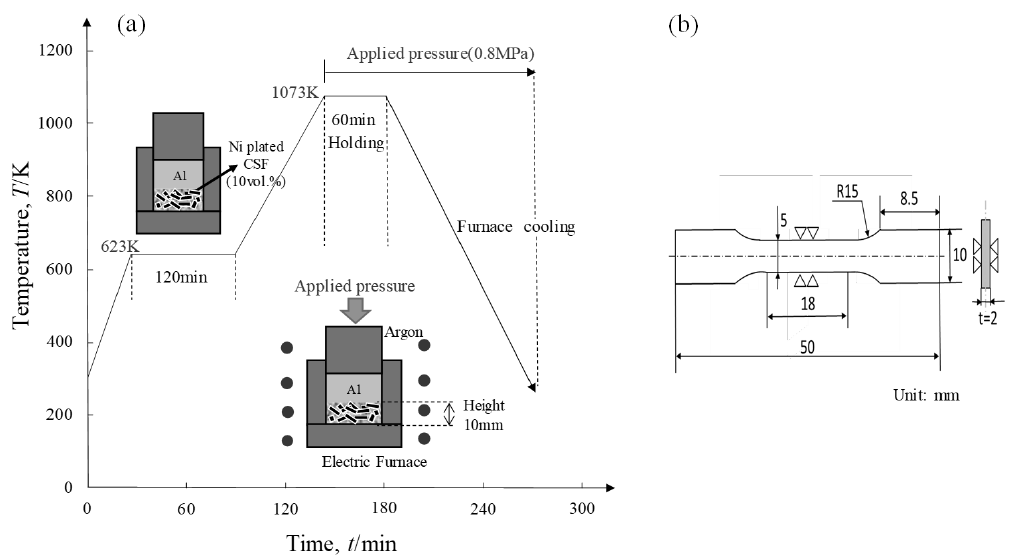
Figure 1. ( a ) Schematic illustration of the new fabrication process without preform manufacturing by low-pressure infiltration method and ( b ) shape and dimension of tensile specimens (unit: mm).